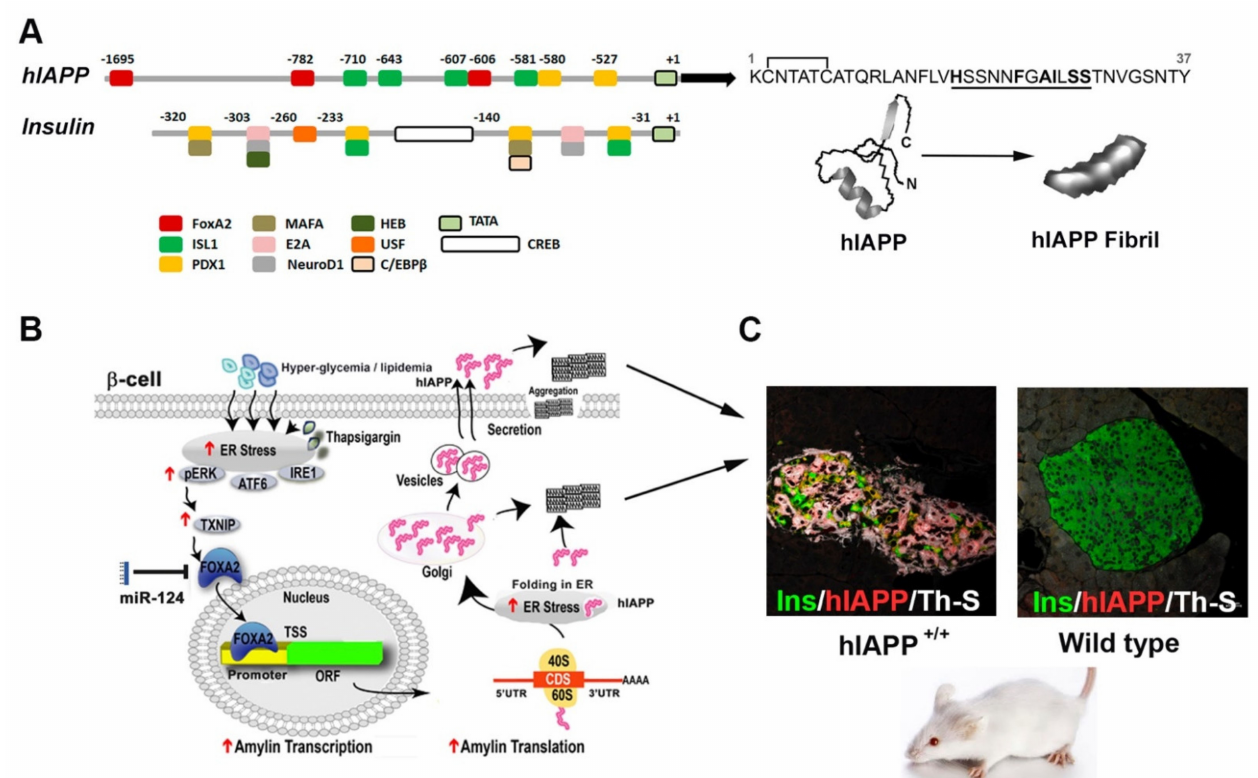
Figure 1. Molecular determinants of hIAPP synthesis, aggregation and toxicity in pancreatic islets. ( A ) Diagram depicts main transcriptional regulatory sites and factors from hIAPP and insulin promot- ers. Primary sequence of fully processed mature hIAPP form is shown on the right. Amyloidogenic region in hIAPP amino acids sequence is underlined. AFM micrograph of a single fibril self-assembled from mature synthetic hIAPP monomers is shown below. Adapted from Reference [46]. ( B ) Diagram depicts main steps in hIAPP synthesis in glucose-challenged or ER-stressed pancreatic β -cells, includ- ing activation of a central TXNIP/FOXA2-mediated signaling pathway. Following processing,